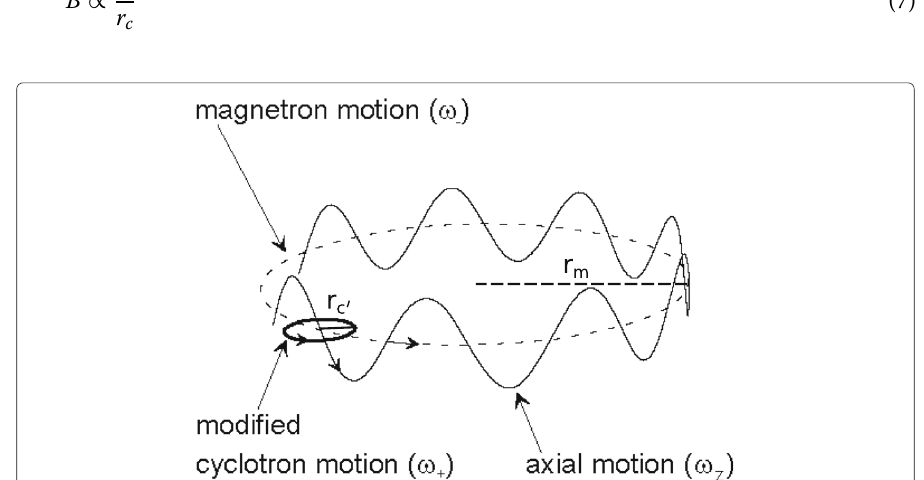
Fig. 2 Single particle motion in QPT. Collisions lead to radial expansion of the particle. r m & r (cid:4) c ≈ r c are respectively the radii of the magnetron and cyclotron